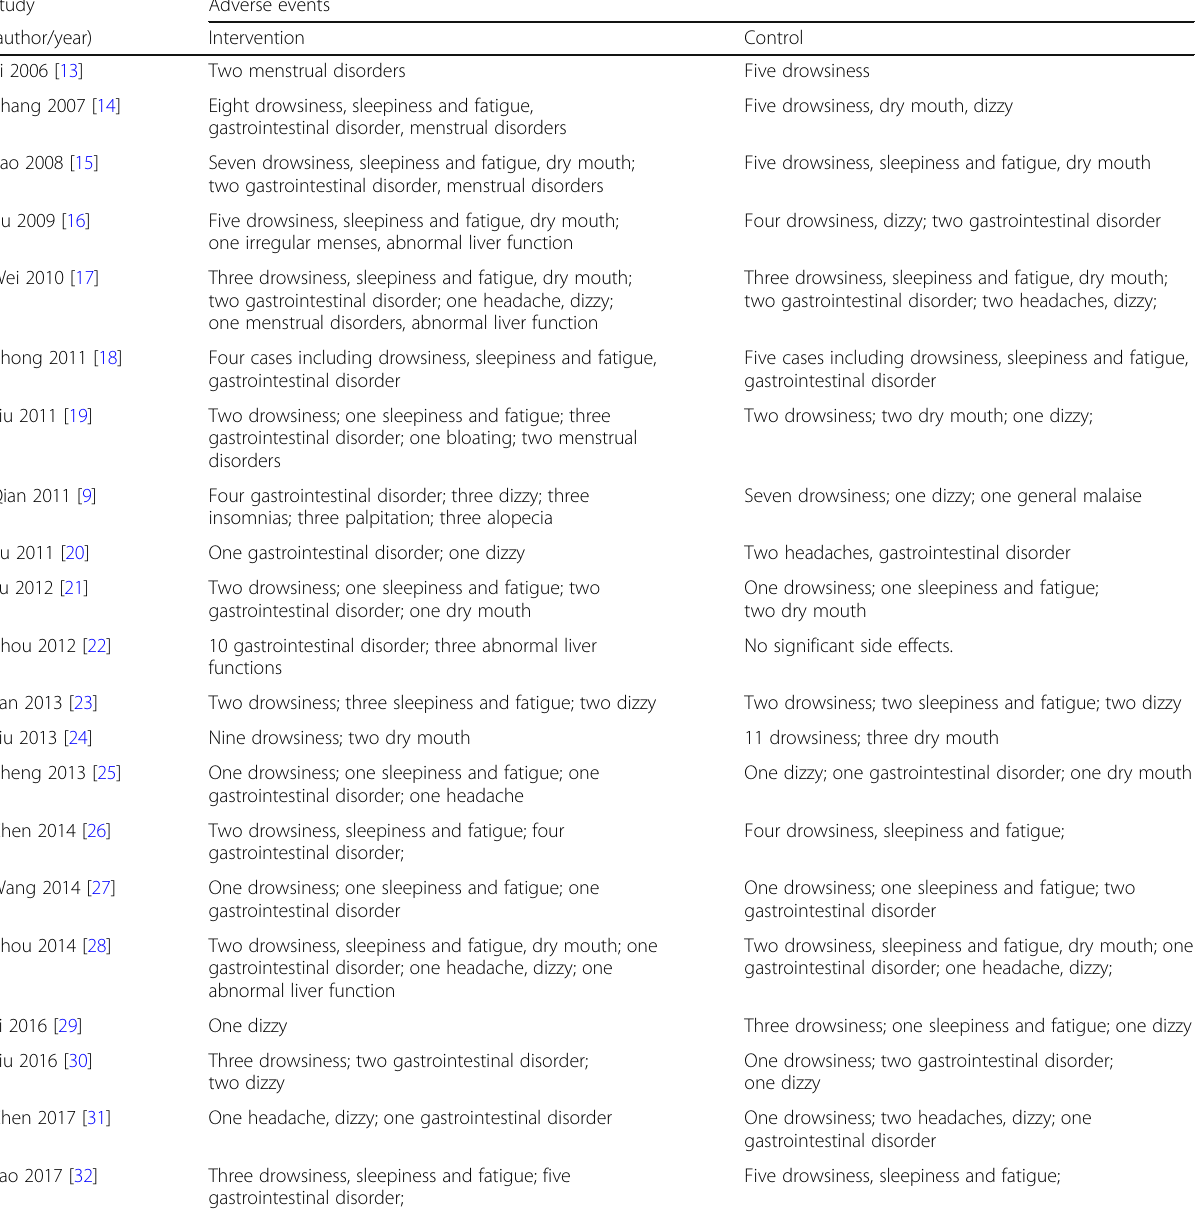
Table 2 Adverse events of included trials